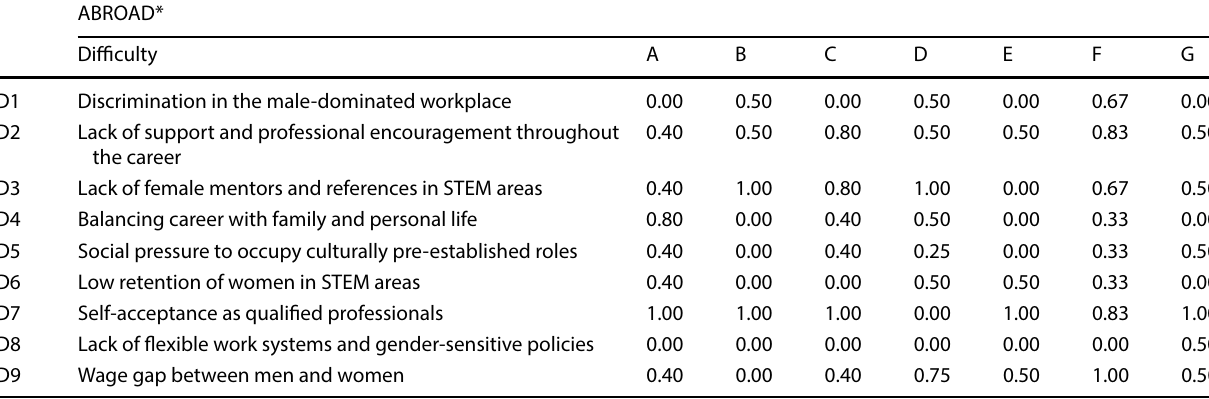
Table 4 Normalization of the scores assigned by the participants for each difficulty